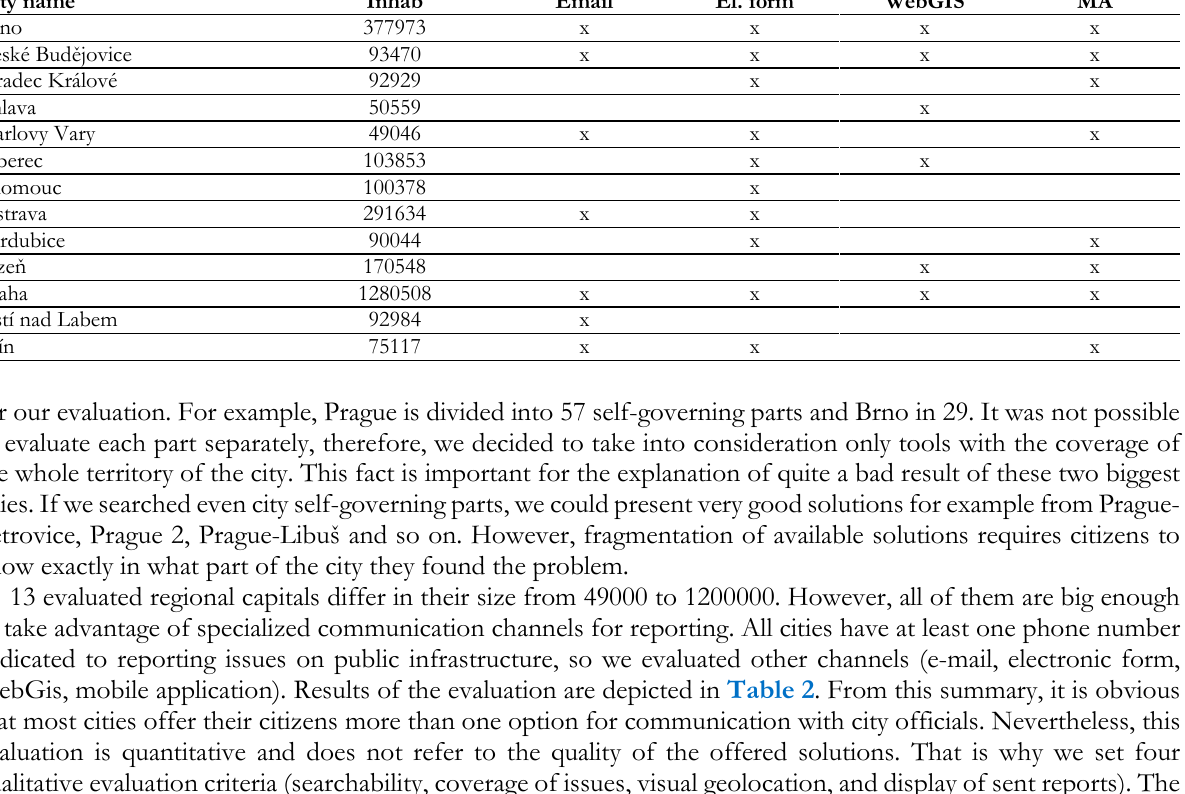
Table 2. Summary of communication channels for citizen reporting (Kopackova and Libalova, 2019) City